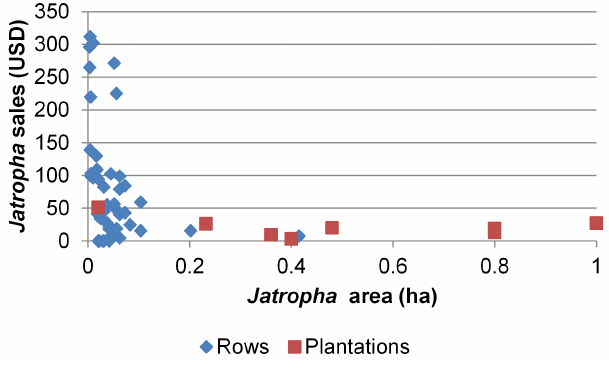
Fig. 3 . Income per unit area under Jatropha for BERL farmers planting Jatropha in hedgerows and block plantations (based on the first season harvest until the time of the survey in March 2013).